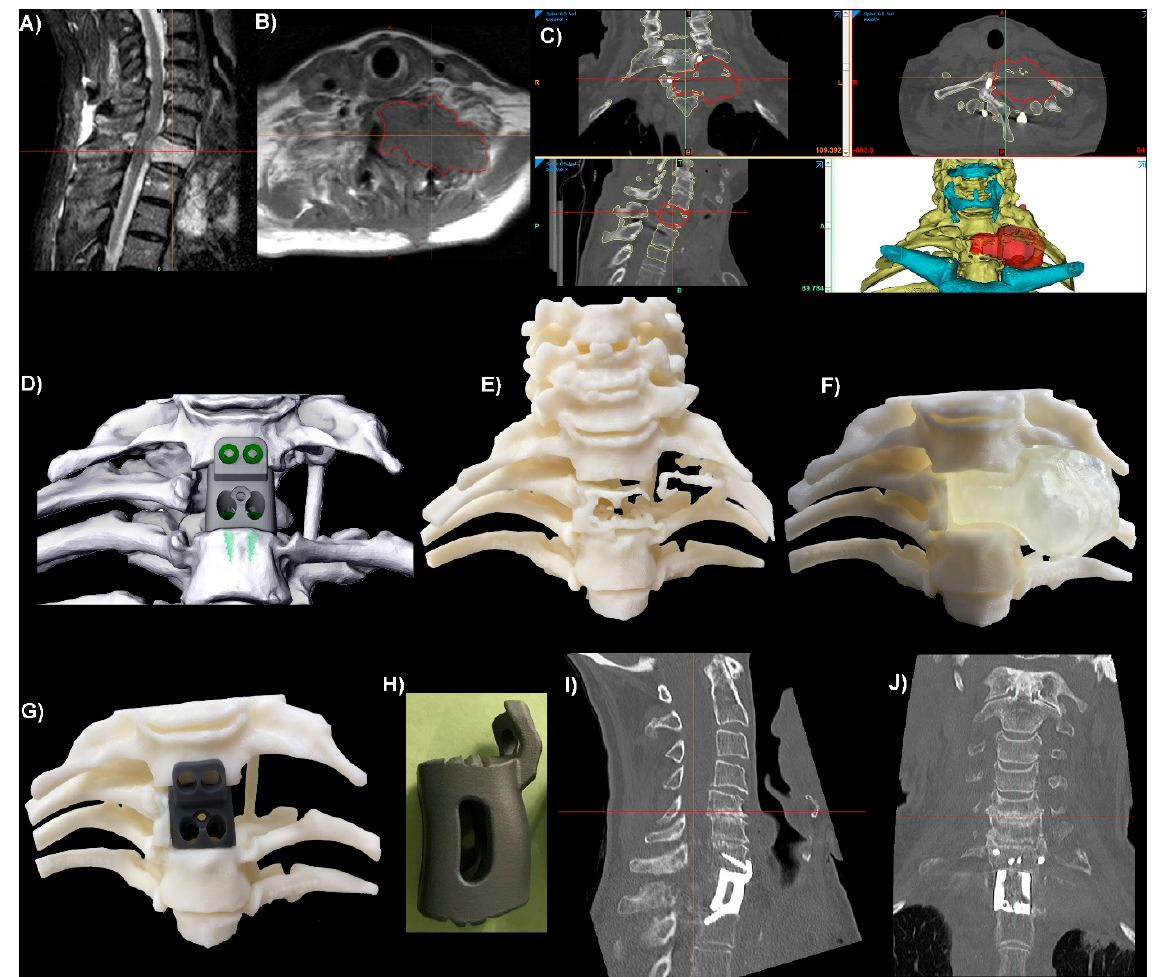
Figure 3. Integral screw fixation thoracic (T1) corpectomy/vertebrectomy patient-specific implant (PSI). ( A ) Sagittal plane MRI slice showing a tumour in the T1 vertebral body. ( B ) Axial plane MRI slice with red outlines showing the tumour. ( C ) CT slices and 3D reconstruction of the anatomy. The hyoid and sternum are shown in cyan. The position of T1 relative to the sternum meant that access to insert screws up into C7 would be difficult, so a custom anterior plate was integrated into the interbody device with anterior–posterior screw trajectories planned for C7. ( D ) Virtual Surgical Plan tumour resection and surgical reconstruction using the PSI and integral screws. ( E ) 3D-Printed ‘biomodel’ of the vertebral and rib bone showing the lytic effects of the tumour on the T1 vertebral and rib bone. ( F ) 3D-Printed biomodels of the vertebral bone with a removable tumour (opaque, colourless). ( G ) Same bone biomodel as (F) with the tumour removed and a 3D-Printed resin ‘demo’ PSI in position. ( H ) Sagittal plane viewpoint of the Titanium alloy (Ti 6 Al 4 V) PSI. One-day postoperative sagittal ( I ) and coronal ( J ) plane CT slices of the level showing good positioning and contact between the PSI and bone.